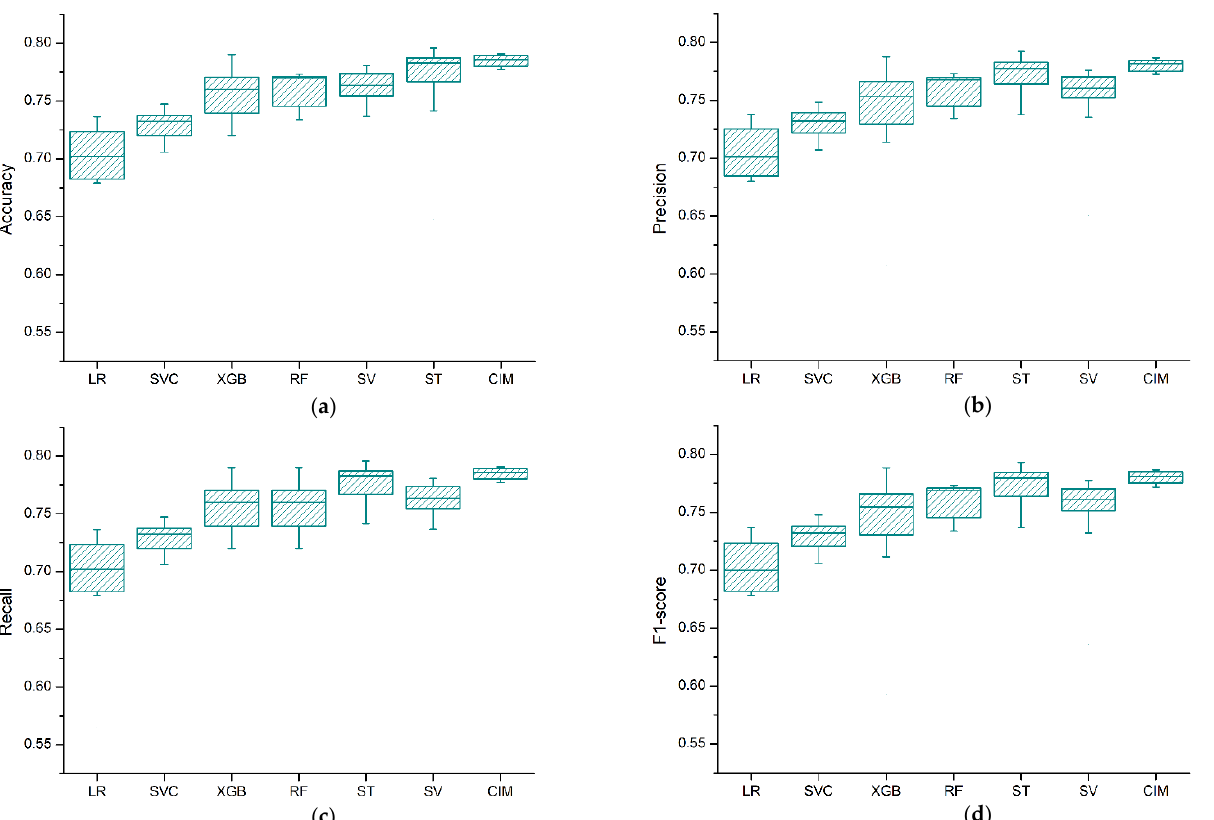
Figure 4. Box plot for the CV score of the prediction models (LR = logistic regression, RF = random forest, XGB = XGBoost, SVM = support vector machine, ST = stacking classifier, CIM = confusion matrix-based classifier integration approach): ( a ) accuracy, ( b ) precision, ( c ) recall, ( d ) F1-score.